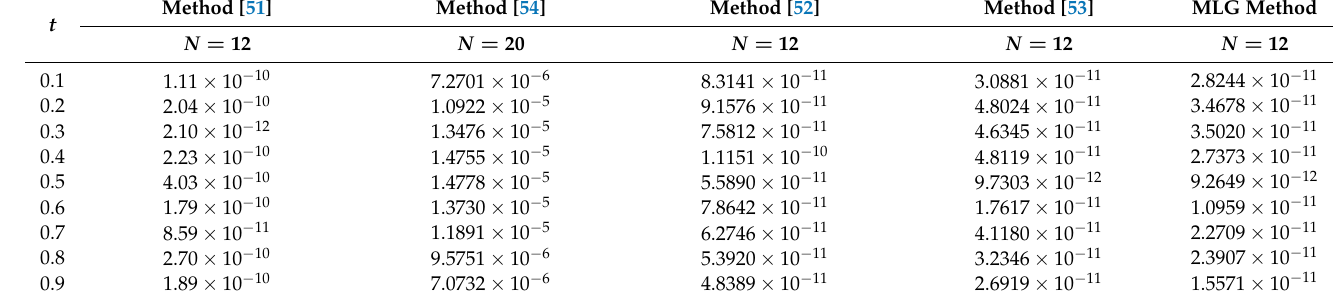
Table 3. Comparison of the errors obtained by the MLG method to the methods in [51–54] schemes, with ν = 1 for Example 3.